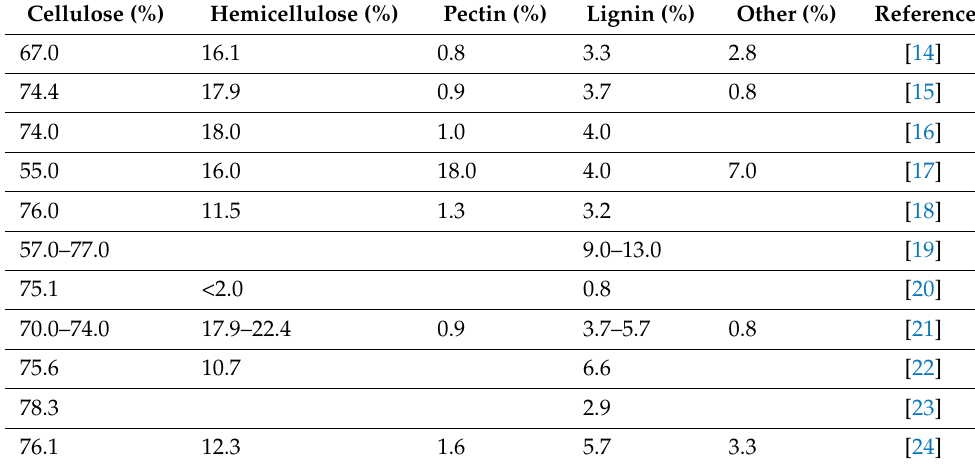
Table 1. Main components of hemp